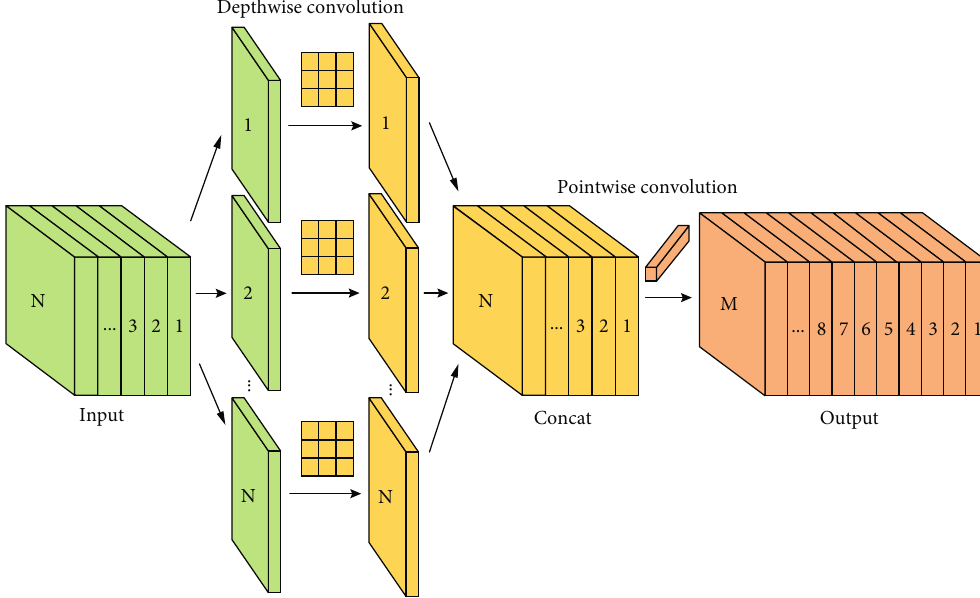
Figure 2: Structure of depthwise separable